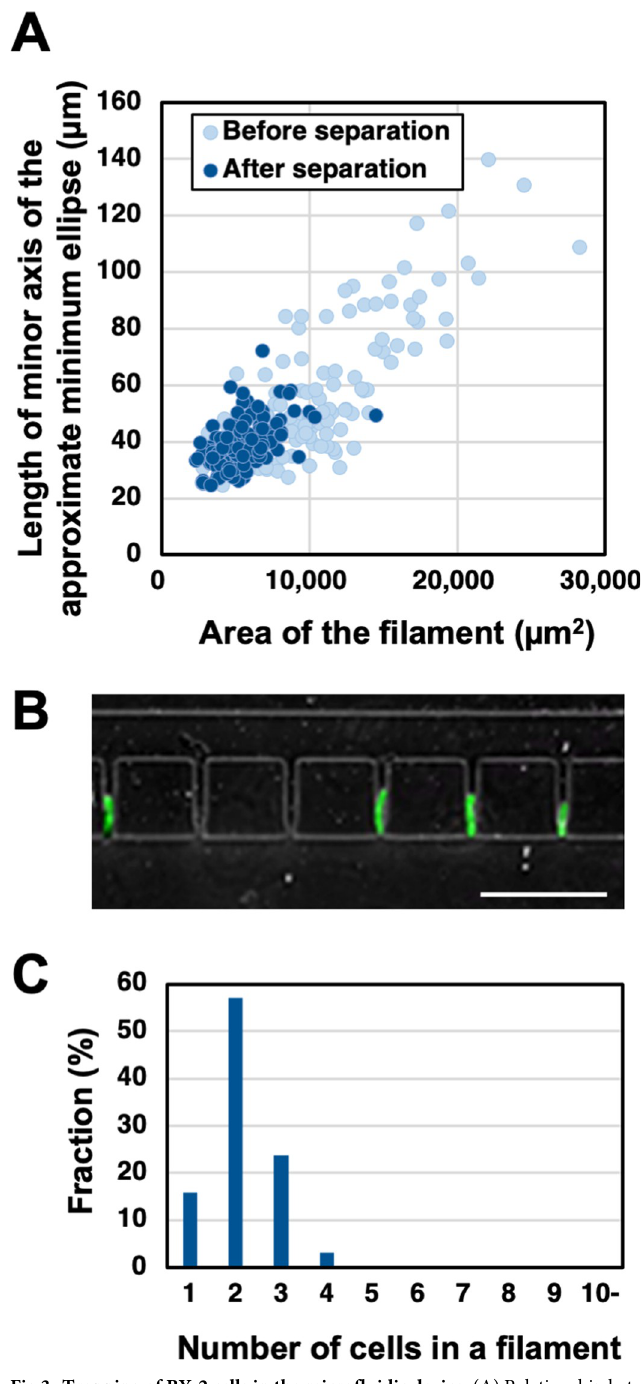
Fig 3. Trapping of BY-2 cells in the microfluidic device. (A) Relationship between length of minor axis of approximate minimum ellipse and area of cell filament. Light blue circle: before cell separation. Dark blue-filled circle: after cell separation. BY-2 cells stained with CellTracker Green were used and 150 filaments were analyzed for each condition. (B) Representative image of trapped cells. Scale bar, 500 μ m. (C) Fraction of number of cells in the trapped filaments in microfluidic